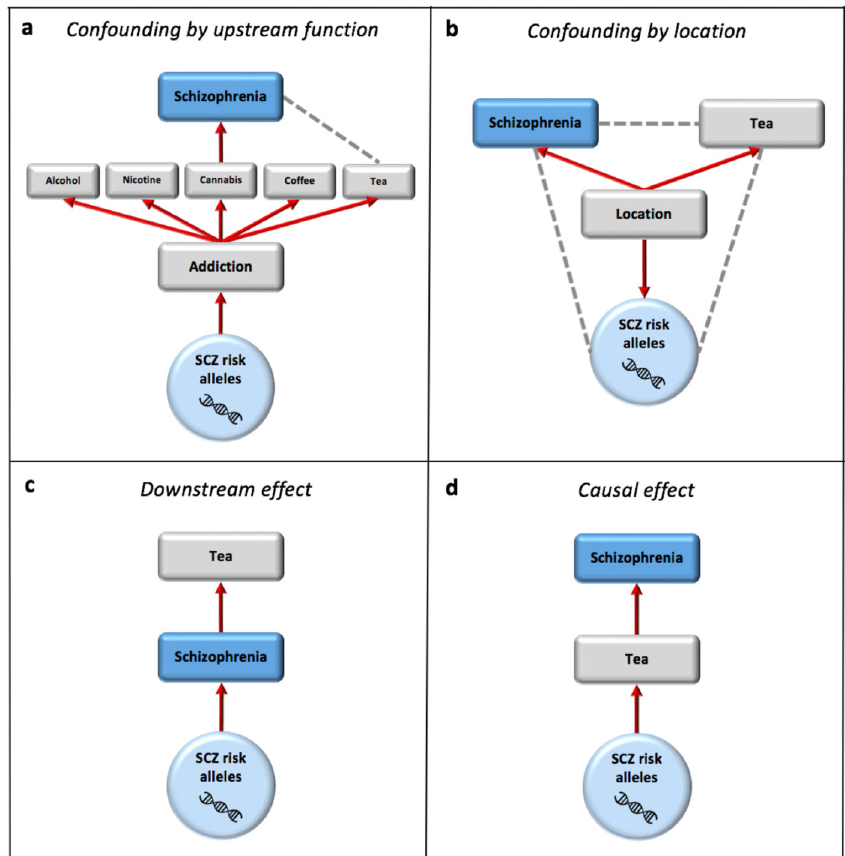
Fig. 3 Four possible causal explanations for the schizophrenia-PRS vs tea drinking association. Red arrows re fl ect causal paths and grey dotted lines depict confounded associations induced by the causal relationships. schizophrenia ‘ risk alleles ’ refer to those included in the PRS, thus comprising genuine schizophrenia risk alleles (/risk haplotypes) and those with no effect on schizophrenia. a Some fraction of schizophrenia risk alleles are addiction risk alleles, which in fl uence addiction to multiple substances. The causal relationship between cannabis and schizophrenia assumed here induces the association between schizophrenia-PRS and tea consumption, confounded-by-function (addiction here, used for illustration only); b schizophrenia risk allele frequencies vary with location (due to genetic drift, etc.) and so too do environmental factors in fl uencing tea consumption and schizophrenia risk, inducing correlations between all three; c schizophrenia risk alleles increase risk for schizophrenia. Schizophrenia increases tea consumption; d schizophrenia risk alleles increase tea consumption. Tea consumption increases risk for